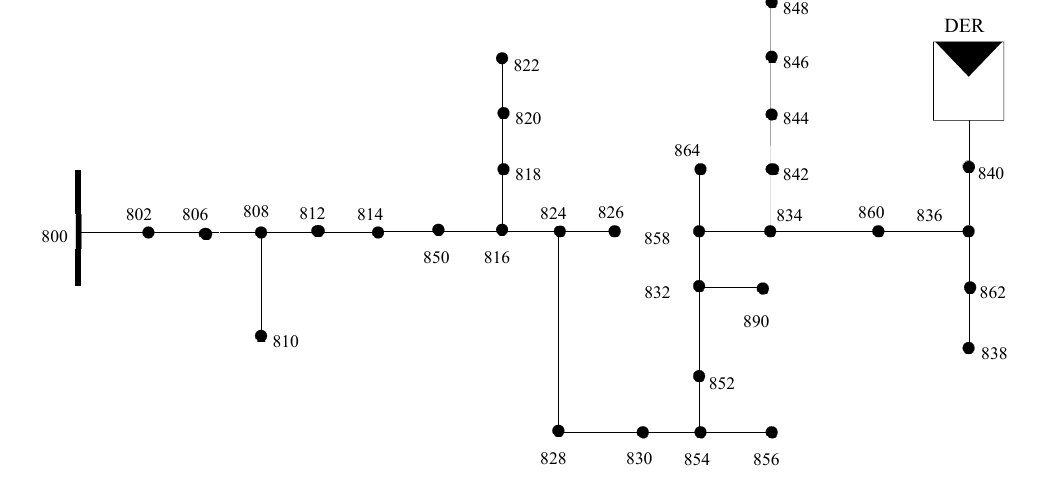
Figure 11. IEEE 34-node test feeder.